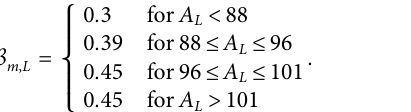
Frontiers in Physics |